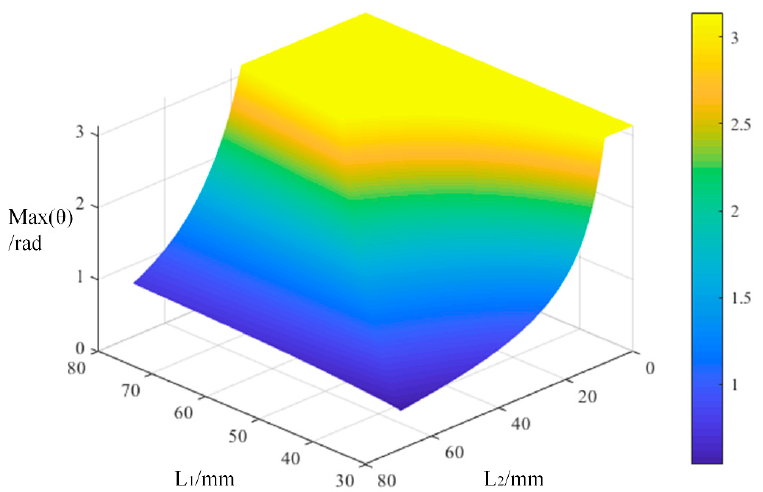
Figure 9. The relationship between the maximum bending angle of the NCR part and the length of each part.